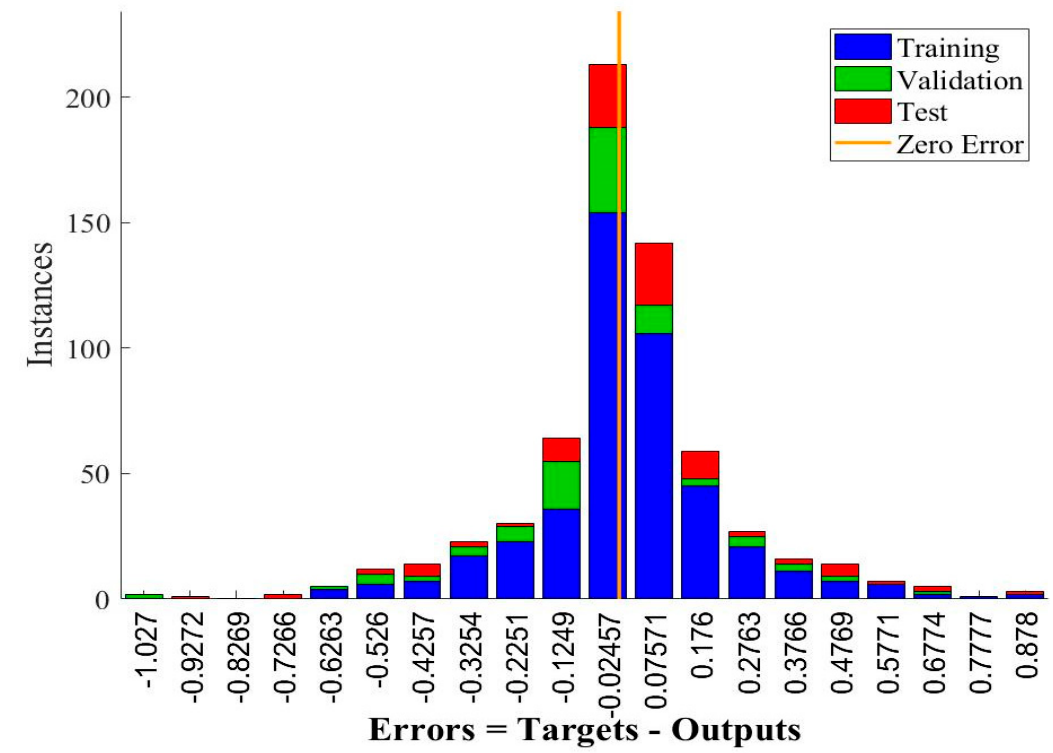
Figure 9. An Error histogram of ANN model.